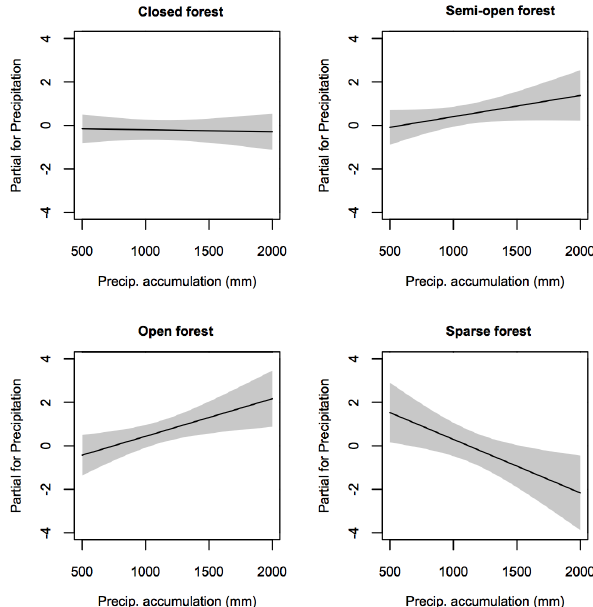
Figure 9. Plots illustrating the predicted odds of landslide occur- rence as a function of precipitation for each forest cover type. These values were predicted under otherwise average conditions for a GAM that included a linear interaction term for forest cover type and precipitation, as well as partly nonlinear representations of the other confounders (topography, rock type and proximity to forest service